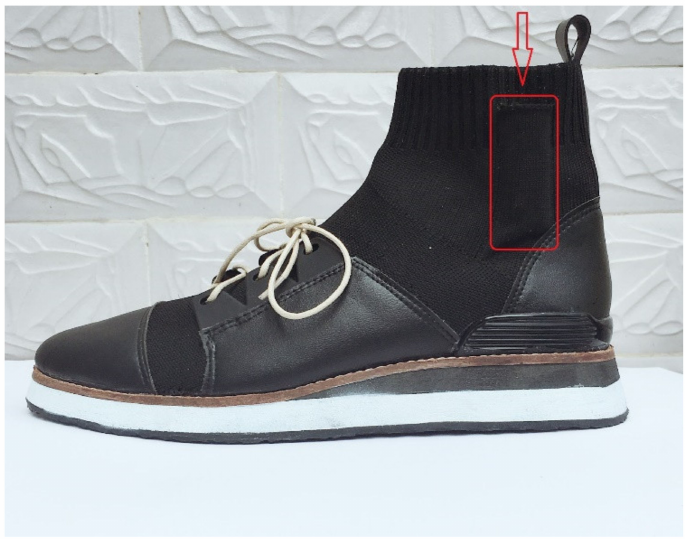
Figure 1. Standardized shoe model used in the present study (the rectangle represents a fit sized pocket to contain the